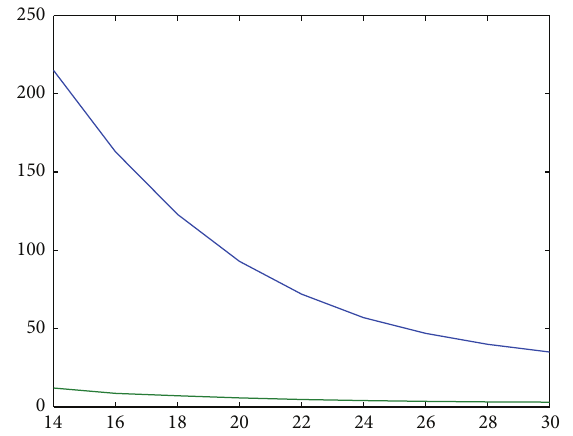
Figure 10: Comparison of convergence rates between an unsuper- vised method and the corresponding supervised